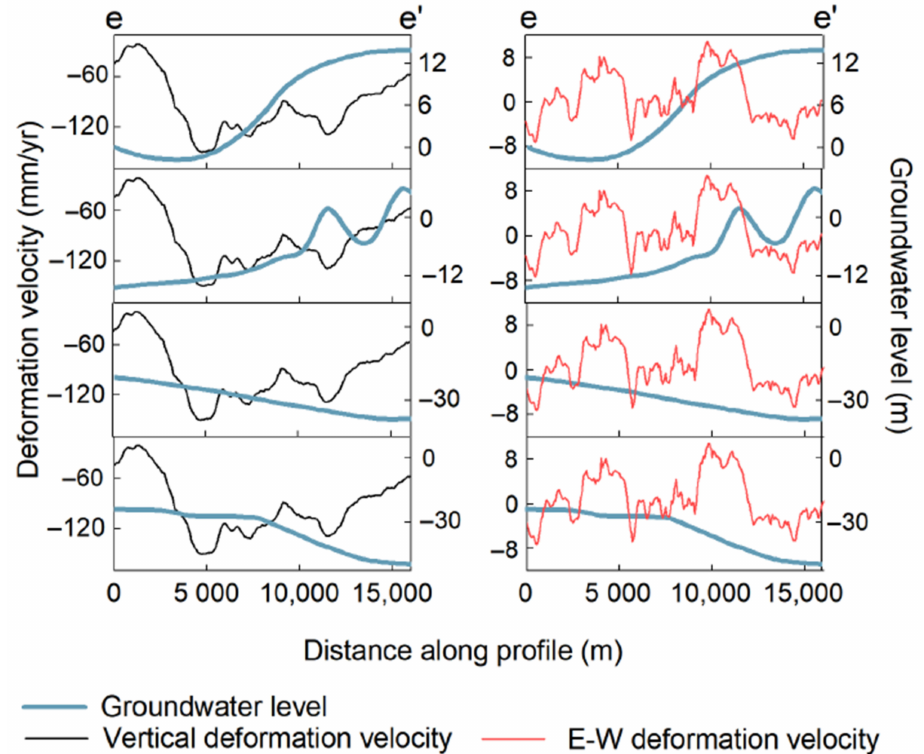
Figure 14. Relationships between the surface displacement and groundwater levels in (from top to bottom) the unconfined aquifer, the first confined aquifer, the second confined aquifer, and the third confined aquifer. Profile e–e (cid:48) is plotted in Figure